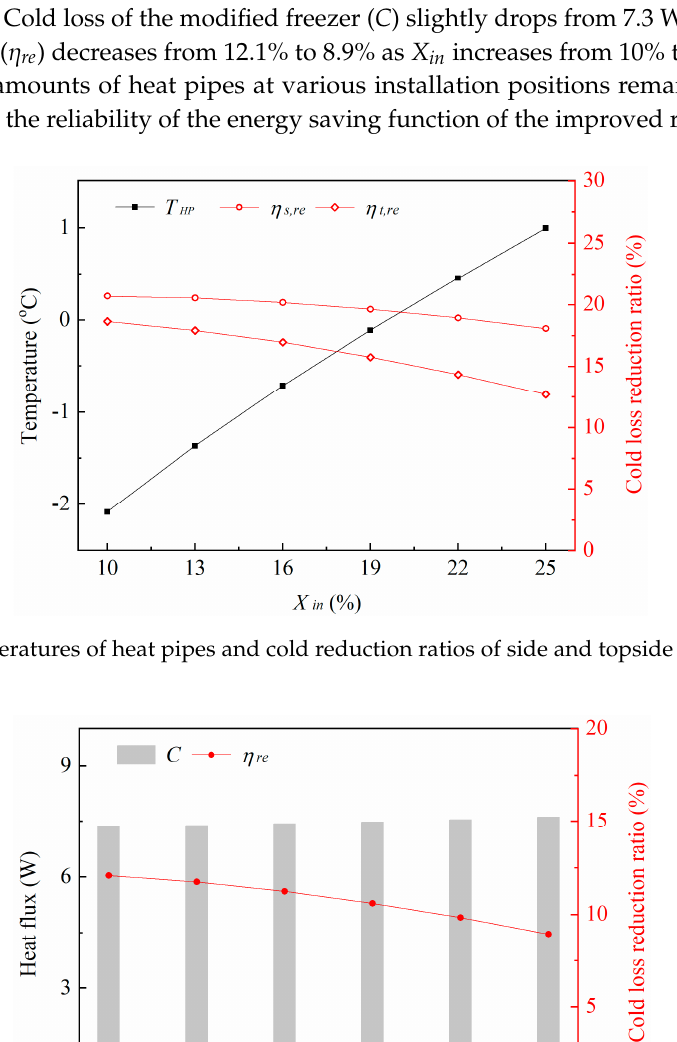
Figure 16. Behaviors of improved refrigerator versus X s,in when X t,in is 16%.